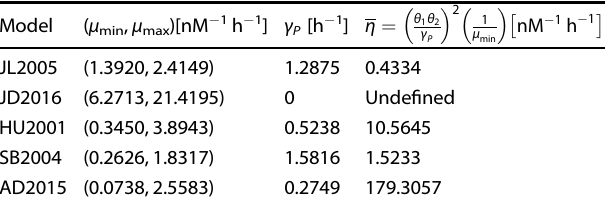
Table 1. Computation of sequestration rate from Eq. 1 with θ 1 = θ 2 = 1 h − 1